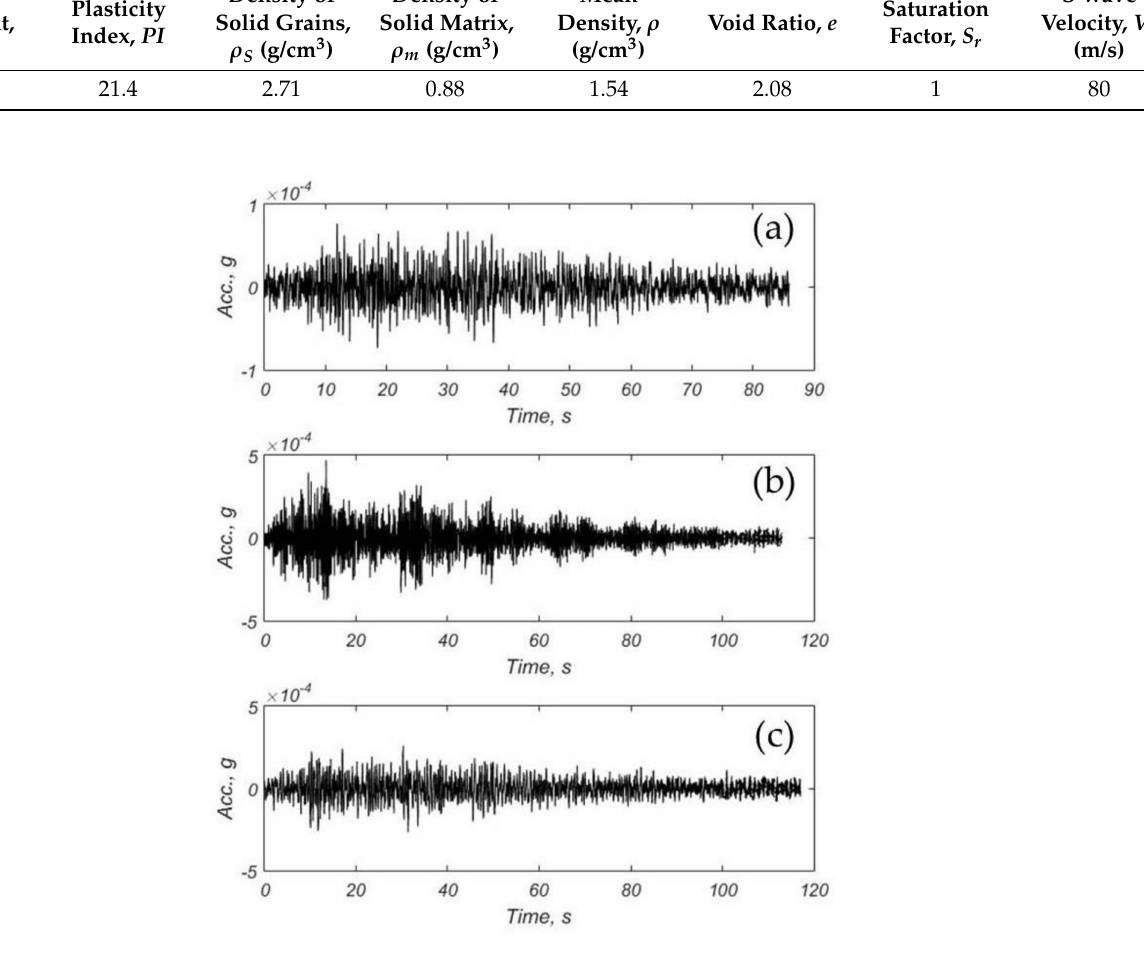
Figure 5. Input signal at bedrock ( a ) and verification signals on the surface of the soft clay layers with the thickness of 5.5 m ( b ) and 14 m ( c ), derived from the OBS